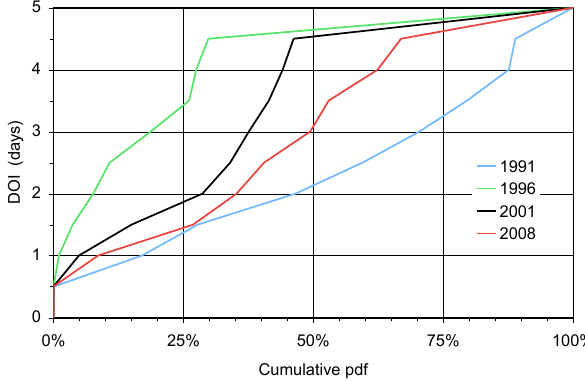
Fig. 2. Cumulative probability distributions of travel times over ice (DOI, days) for the Oden expeditions in 1991, 1996, 2001, 2008. All travel times beyond five days are given the value